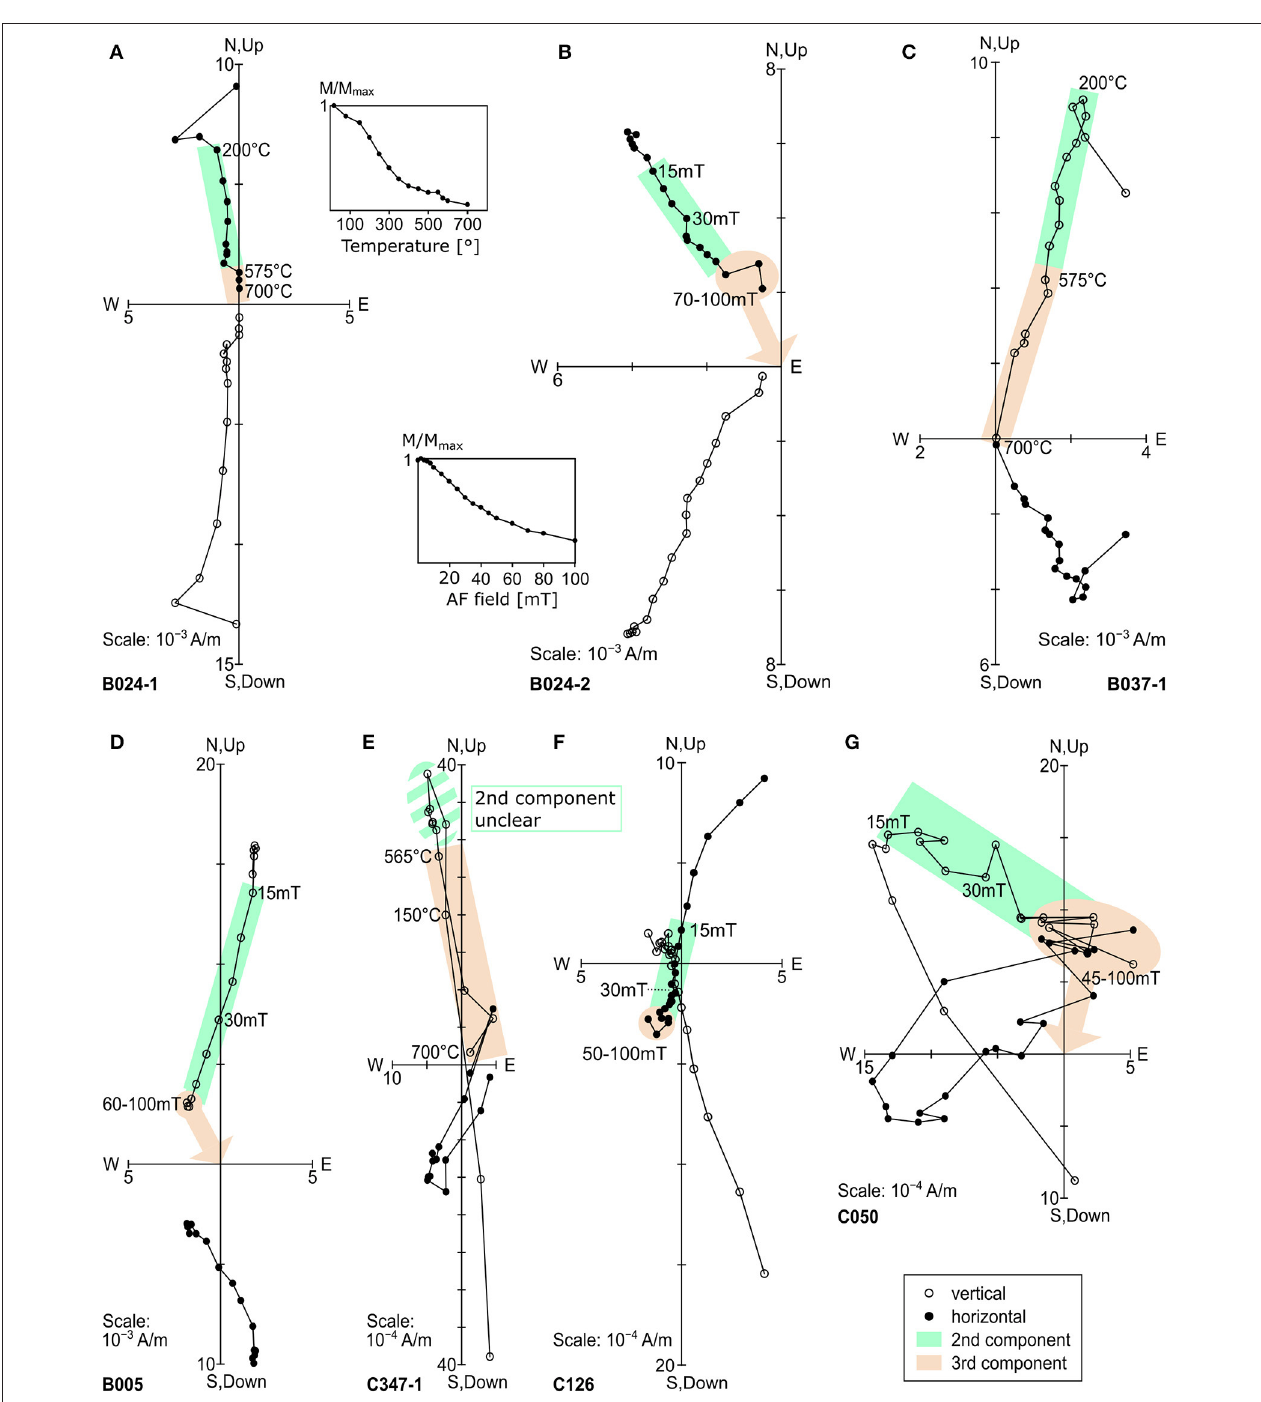
FIGURE 3 | Orthogonal end-vector projections of thermal and alternating field demagnetization data (stratigraphic coordinates) for representative samples from the Bastau Fm. Sample names are in bold. The determination of the second and third components is demonstrated in green and red (first component removed below 15 mT or below 200 ◦ C not marked). For the third component, clustering directions at high AF steps are forced to the origin (arrows, in F omitted for clarity).